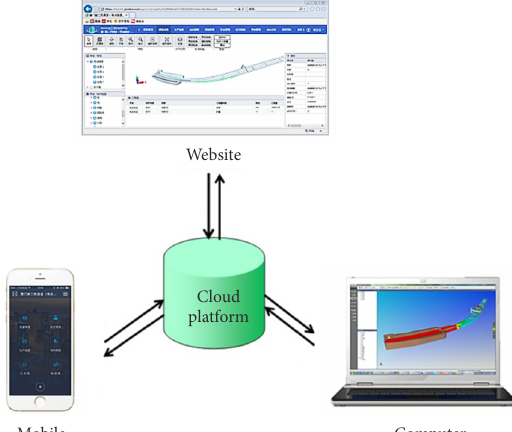
Mobile Figure 12. The three clients (mobile\computer\website) can exchange project data through the Cloud Platform